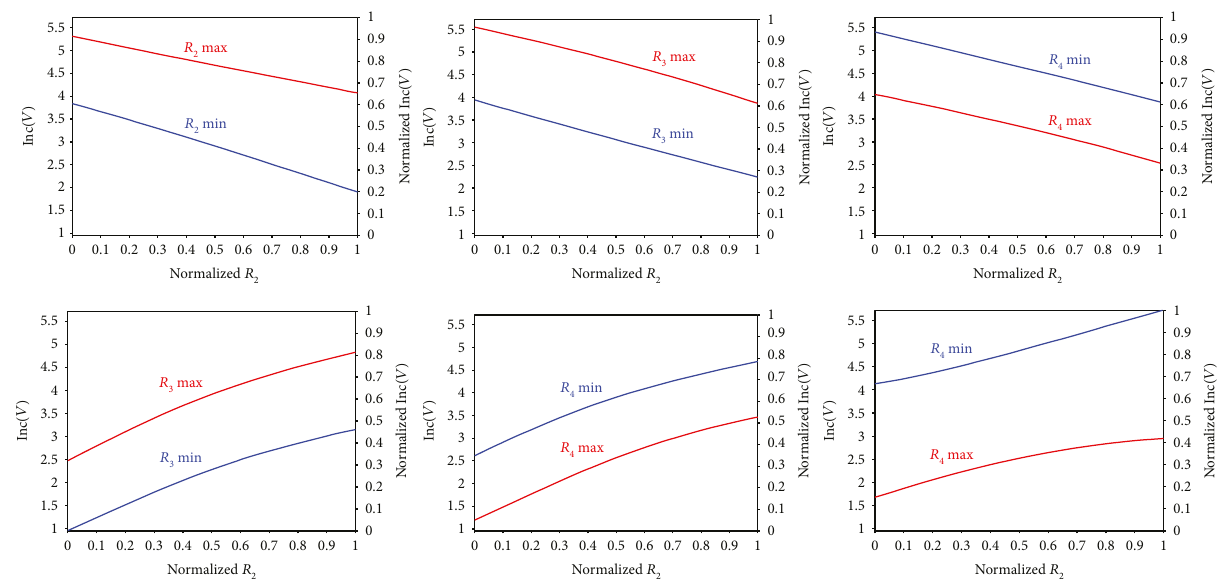
/ I C B values obtained with the ANN.